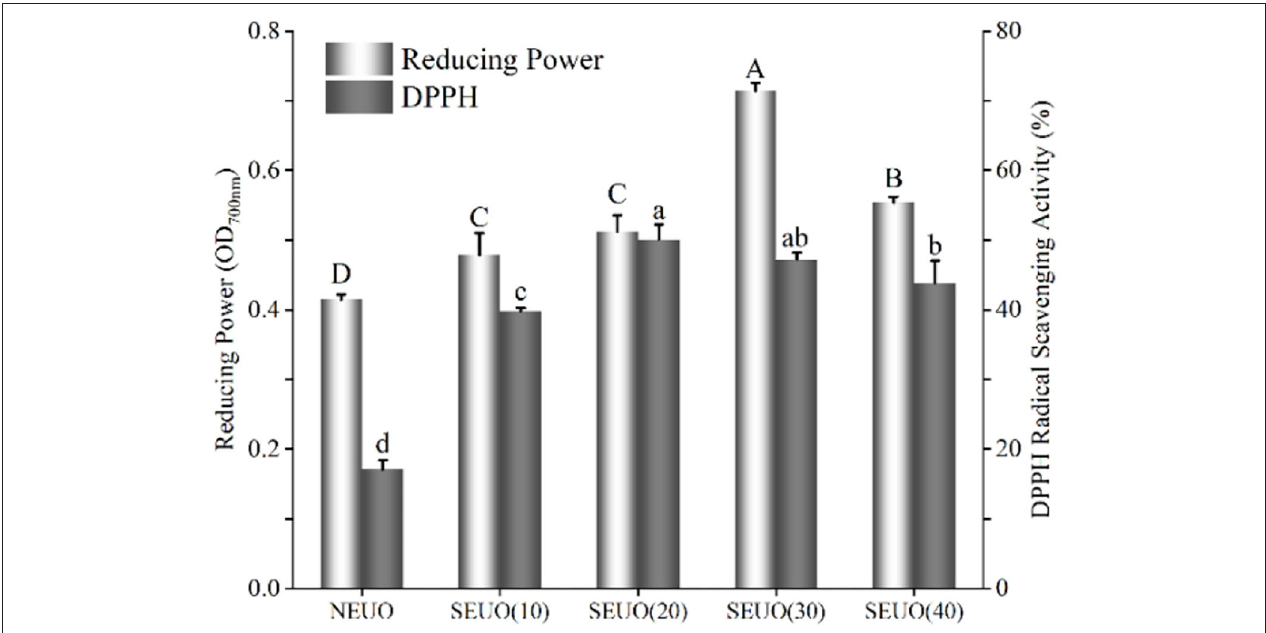
FIGURE 3 | Effect of steam explosion on antioxidant capacity of Eucommia ulmoides Oliver bark extracting solution. DPPH, DPPH radical scavenging activity; NEU, native Eucommia ulmoides Oliver bark; SEU, steam-exploded Eucommia ulmoides Oliver bark, SEU(10) to SEU(40) indicated steam explosion retention time was 10–40min, respectively. (Means that do not share a letter are significantly different, p < 0.05). Different letters in data bars represent significant differences at p < 0.05 as determined by Duncan’s multiple range test.